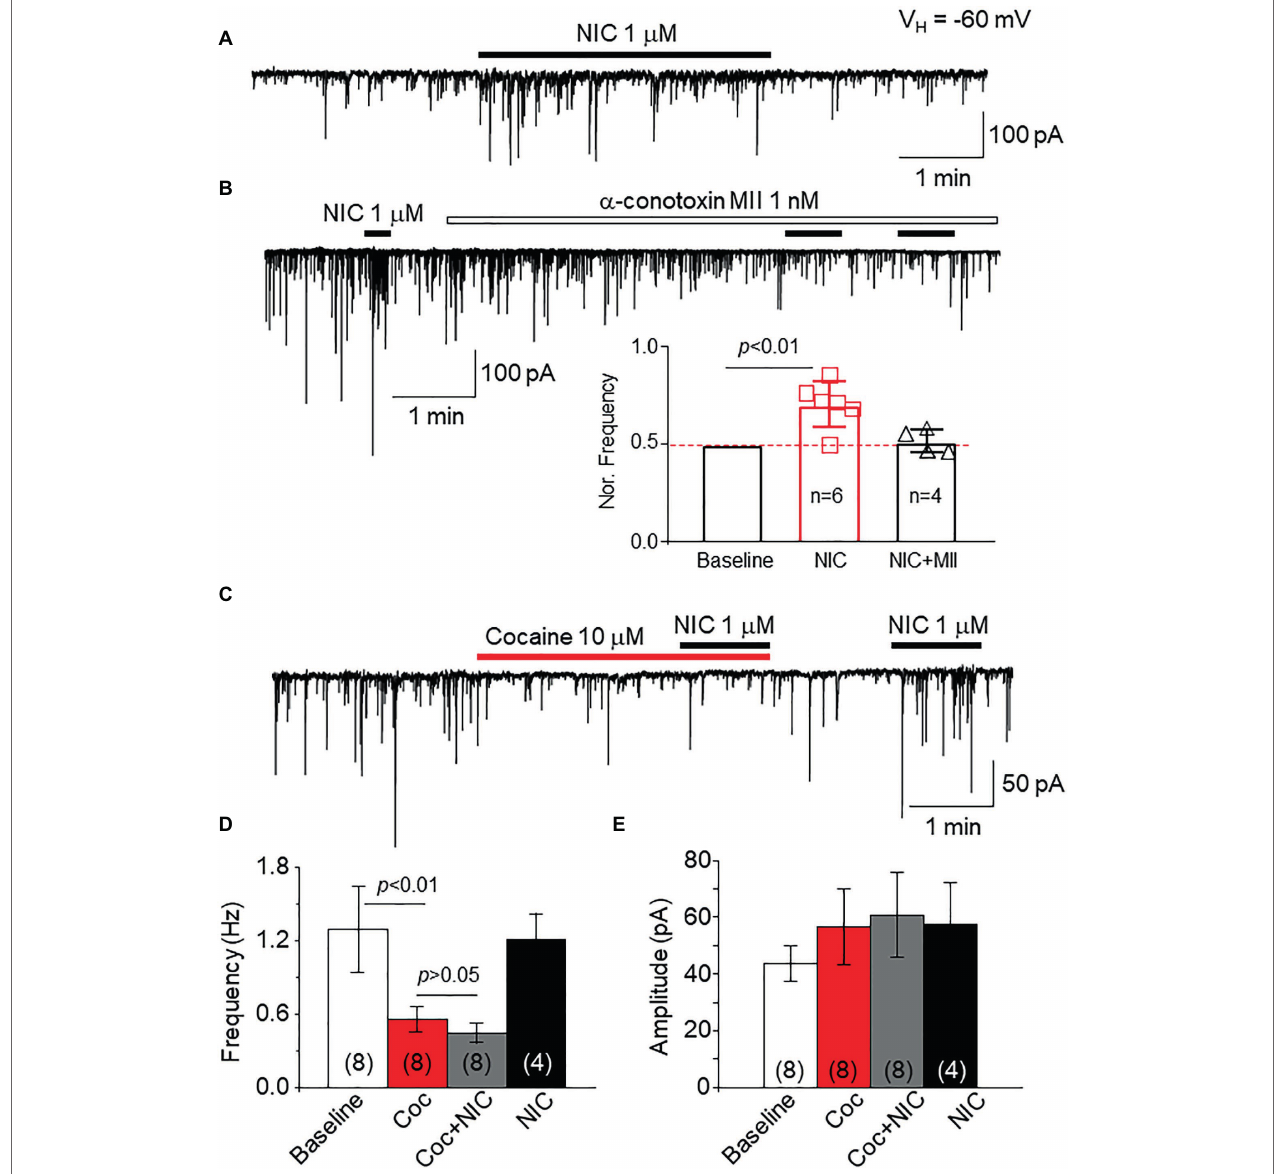
FIGURE 9 | Cocaine inhibits natural α 6*-nAChRs expressed on GABAergic boutons on VTA DA neurons. (A) In mechanically dissociated VTA GABA neurons, patch- clamp whole-cell recording in voltage-clamp mode demonstrated sIPSCs and bath application of 1 μ M NIC enhanced sIPSC frequency. (B) Pretreatment with the α 6*- nAChR selective antagonist, α -conotoxin MII (1 nM for 5 min) prevented NIC-induced effect, suggesting that α 6*-nAChRs mediate the NIC effect. (C) Bath application of cocaine (10 μ M) reduced the sIPSC frequency, and in the presence of cocaine, NIC faired to enhance sIPSCs. After washout of cocaine for 1 min, NIC enhanced sIPSCs. Statistical analysis of the effects of cocaine on sIPSCs and NIC-induced effect demonstrated that compared to a baseline level, cocaine significantly reduced the sIPSC frequency, and in the presence of cocaine, NIC faired to enhance sIPSC frequency (D) . However, cocaine did not affect sIPSC amplitude (E)